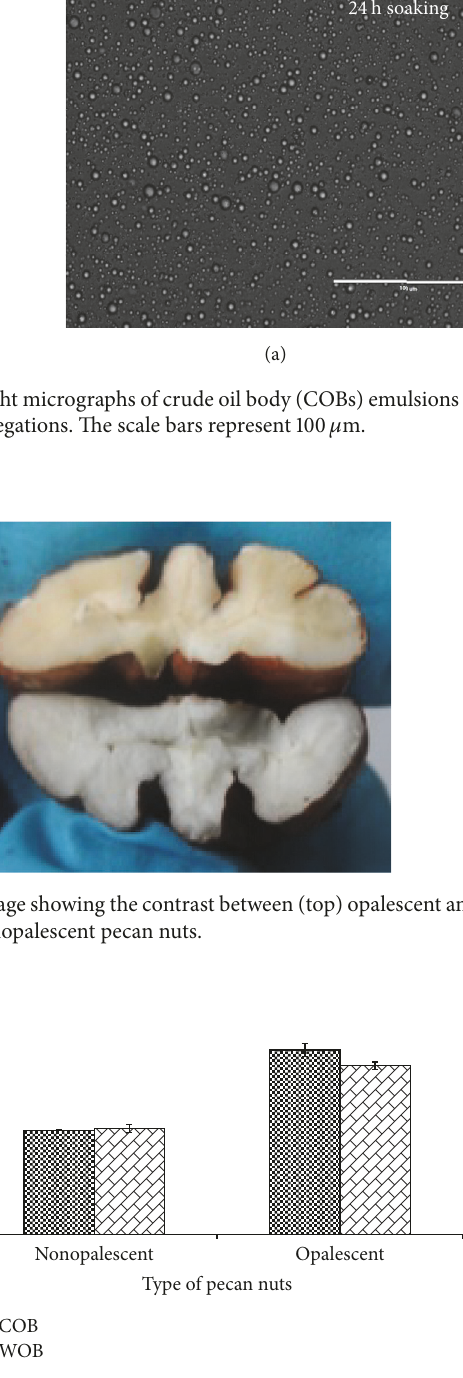
Figure 10: Average particle sizes of both crude oil body (COBs) and washed oil body (WOBs) emulsions of opalescent and nonopales- cent pecan nuts.